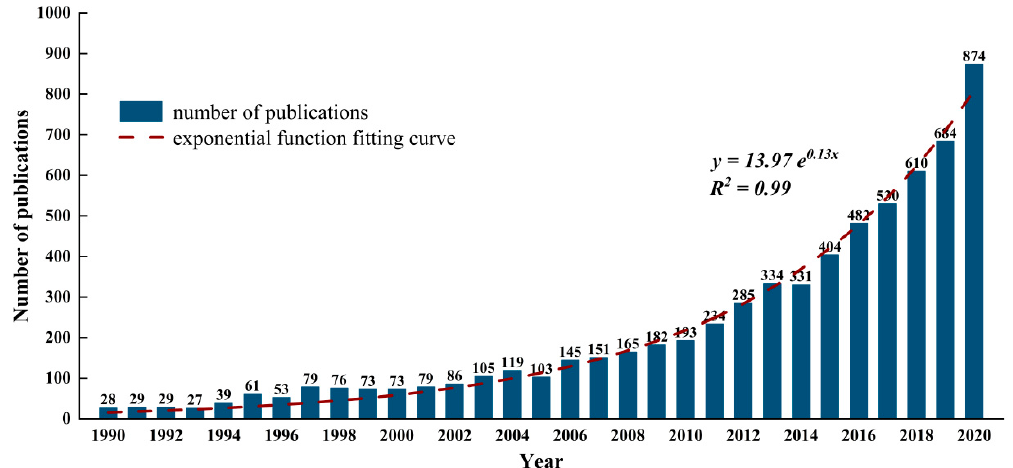
Figure 2. Number of publications and growth